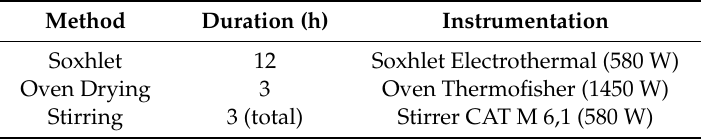
Table 9. Instrumentation and methods for nanomaterials